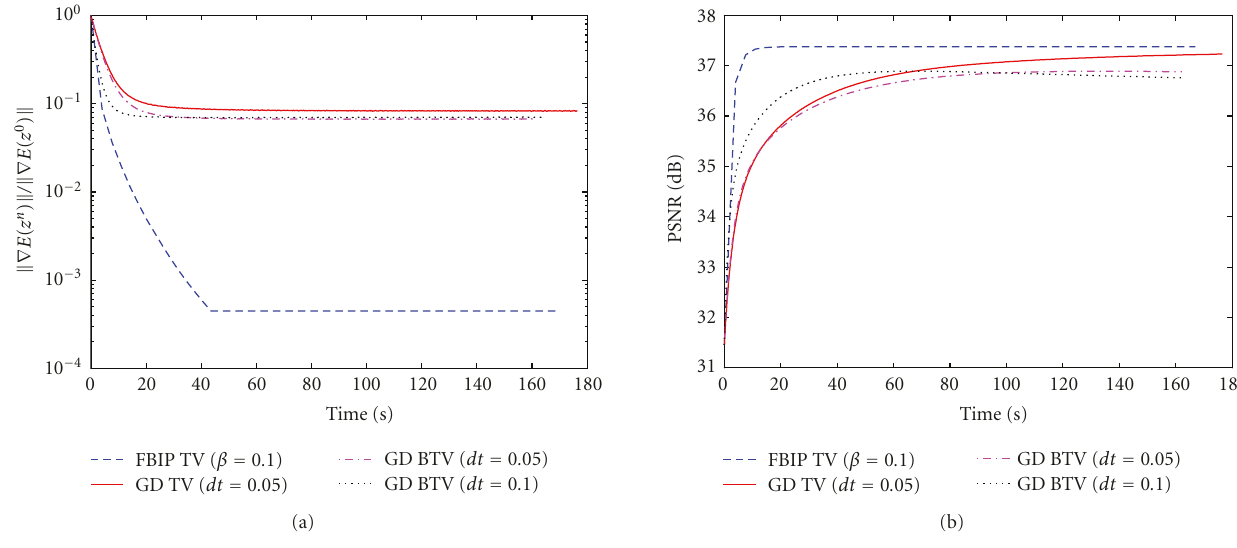
Figure 15: Convergence performance of di ff erent algorithms, (a) measured by gradient norm, (b) measured by PSNR value.